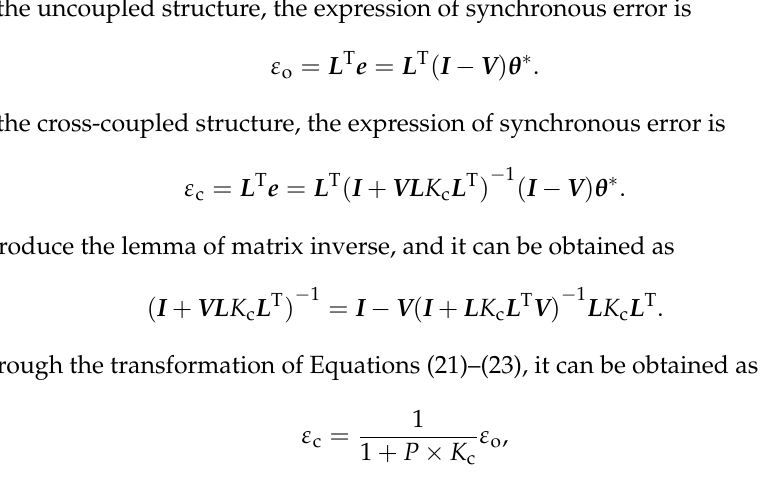
Figure 10. Schematic diagram of cross-coupled position synchronous compensator.